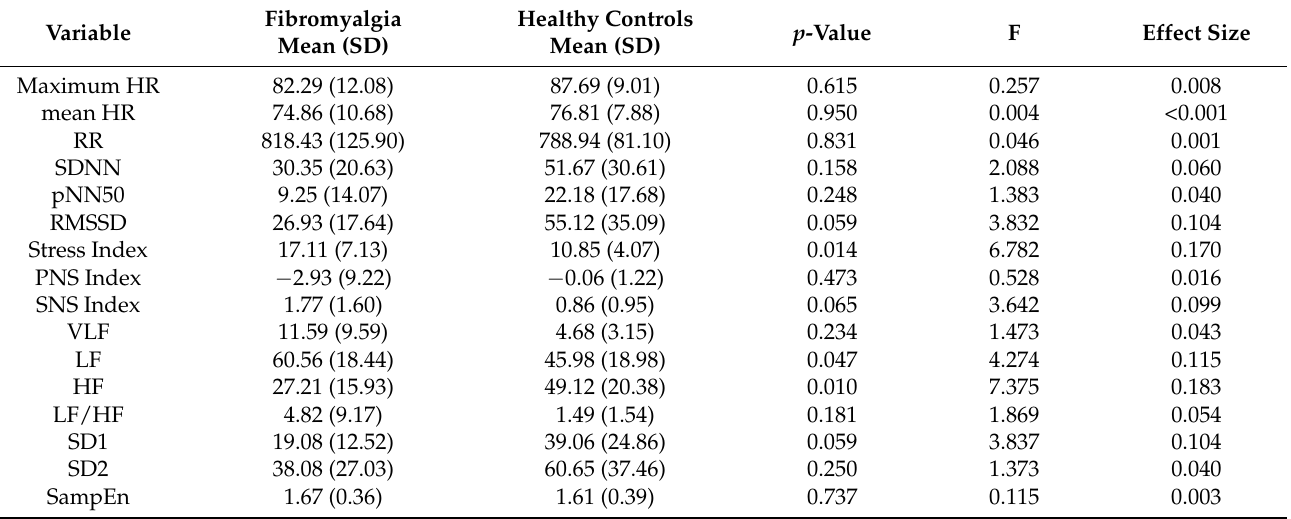
Table 1. Differences in Heart Rate Variability between people with fibromyalgia and healthy controls at